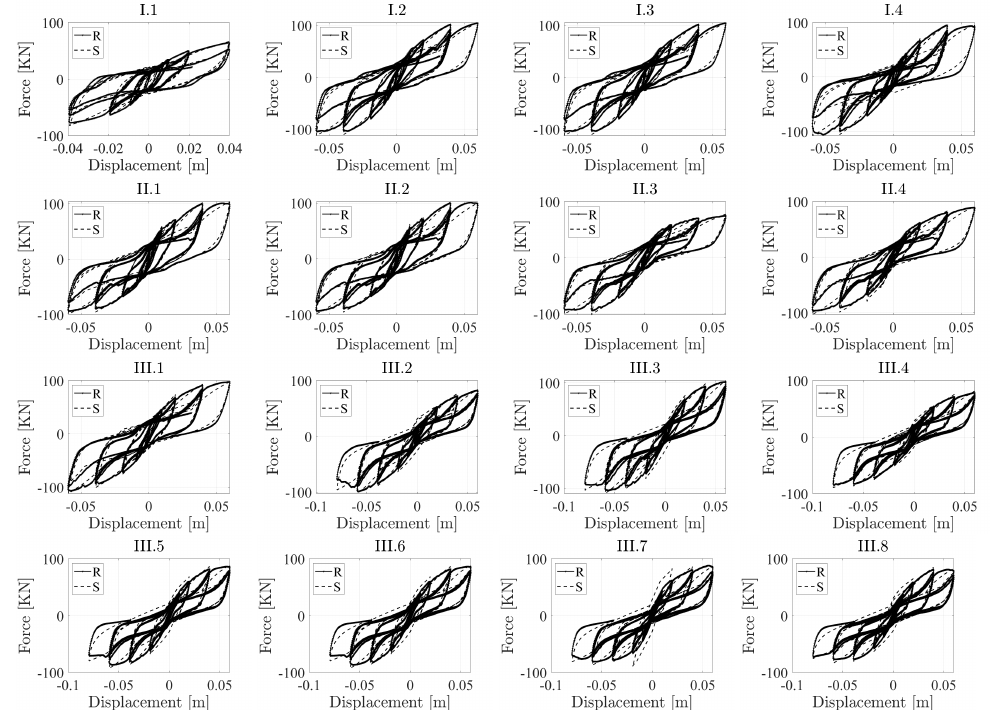
Figure 5. Superposition of the experimental (continuous) and simulated (dashed) hysteresis loops. Both the Sobol index Sj and the total sensitivity index S T